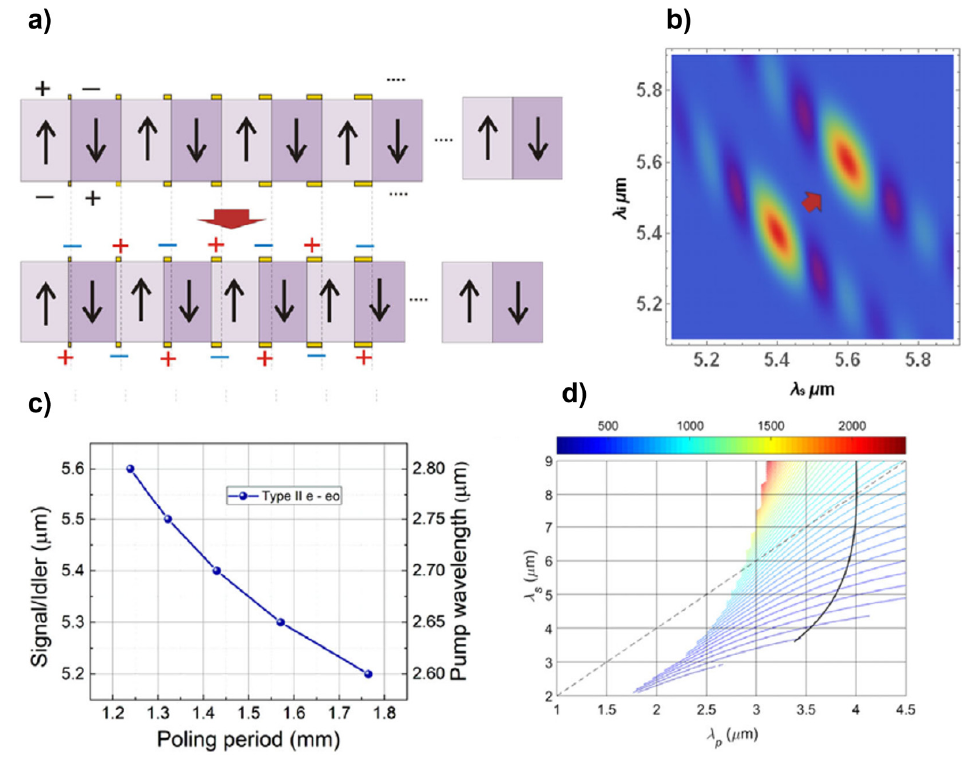
Figure 10. ( a ) Representation of the switching mechanism of the poling period of the PP-PMN-PT crystal, applying the electrode mask shown in figure as yellow bars. The poled domains of the crystal are illustrated with alternating colors; the arrows represent the direction of the spontaneous polarization. ( b ) Joint spectral amplitude corresponding to the two poling period configurations shown in ( a ). ( c ) Dynamic range of the signal/idler wavelength corresponding to different modified poling periods for the degenerated PDC; ( d ) complete range of signal wavelengths including the nondegenerate type-II PDC processes; the color lines indicates the poling period Λ (top bar in microns). Reproduced with permission from [58], copyright 2020.